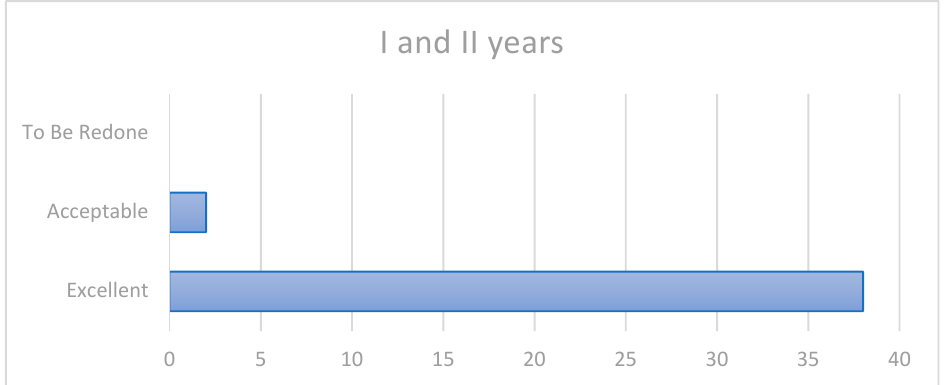
Figure 1. First and second years’ outcomes.